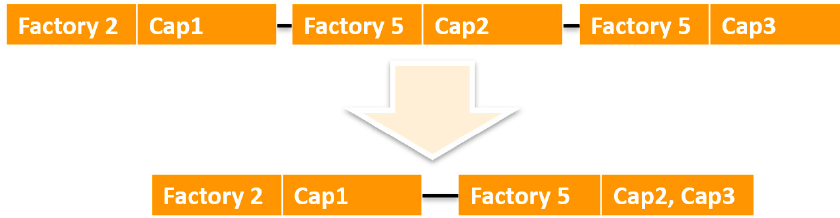
Figure 10. Merged factory combinations.